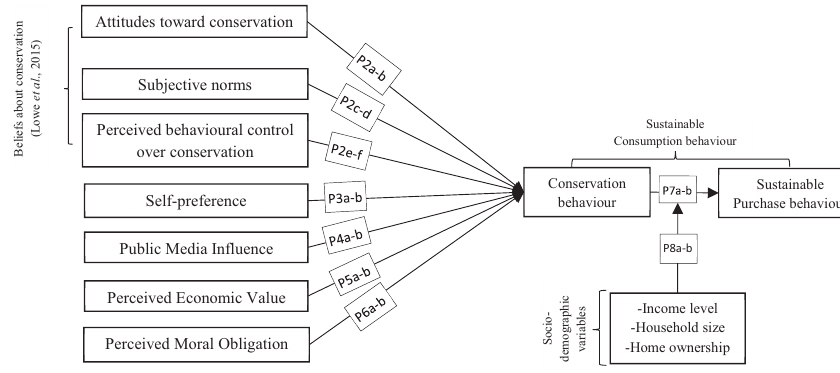
Figure 1. Conceptual